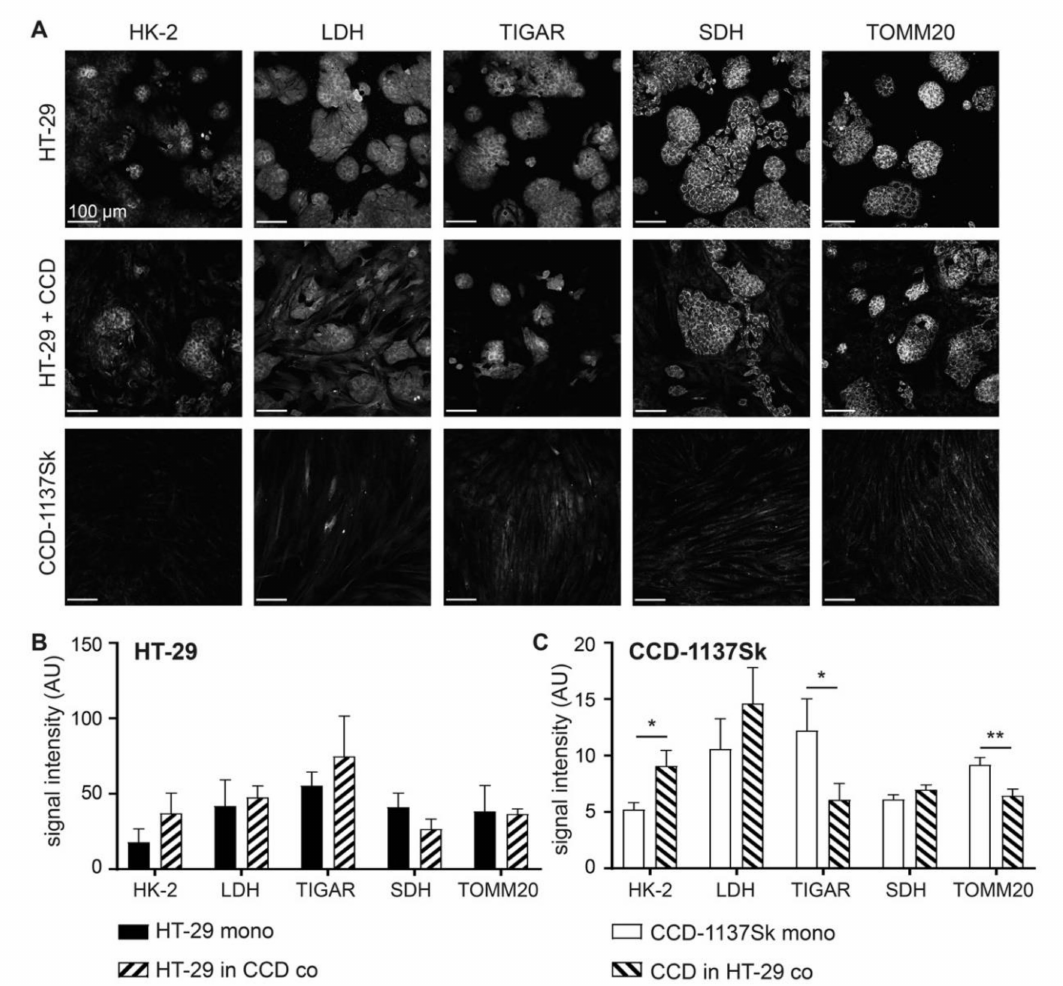
Figure 2. Fibroblasts in monolayer co-cultures of HT-29 and CCD-1137Sk show enhanced glycolytic and reduced oxidative phosphorylation markers. HT-29 and CCD-1137Sk cells were either seeded alone or in co-culture and grown to a sub-confluent state for four days. Then, cells were fixed and stained with DAPI as well as antibodies against HK-2, lactate dehydrogenase (LDH), TP53-induced glycolysis and apoptosis regulator (TIGAR), succinate dehydrogenase (SDH), and: translocase of outer mitochondrial membrane 20 (TOMM20) as markers for nuclei, glucose breakdown, pyruvate-lactate metabolism, negative glycolysis regulation, oxidative phosphorylation, and mitochondrial content, respectively ( A–C ). ( A ) Representative confocal images of fluorescence staining for markers and cultures as indicated. B and ( C ) Graphs show quantitative analysis of fluorescence intensity values for markers and cell types as indicated. Mean + SEM ( n = 3 experiments; * p < 0.05, ** p <